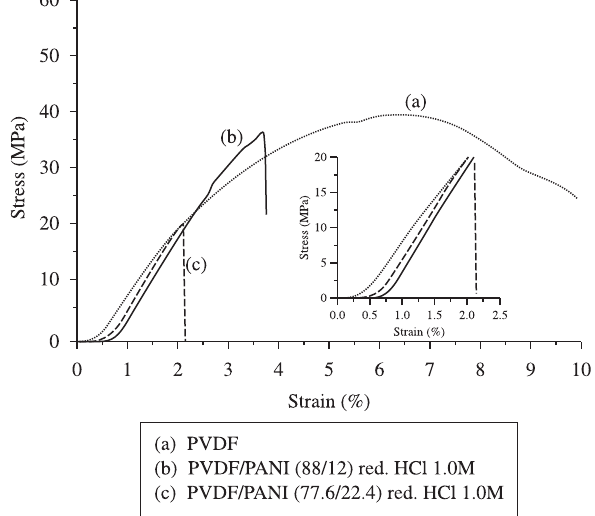
Figure 9. The DMA measured storage modulus and tan δ of the PVDF/ PANI (12 wt. (%) PANI), PVDF/PANI (22,4 wt. (%) PANI) and PVDF/PANI (30 wt. (%) PANI). The blends are dedoped.